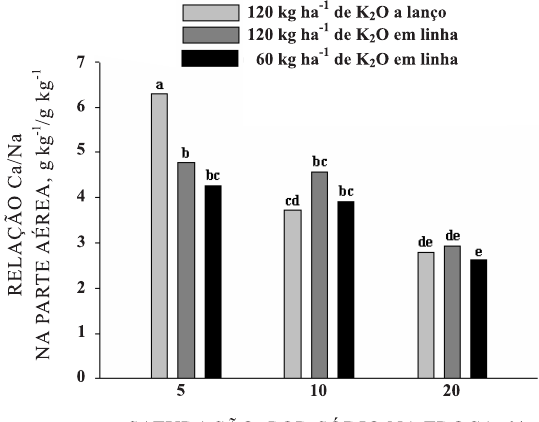
Figura 3. Relação cálcio/sódio na parte aérea de plântulas de arroz, em função do manejo da adubação potássica e dos níveis de salinidade no solo. Médias seguidas pela mesma letra não diferem entre si pelo teste DMS, a 5